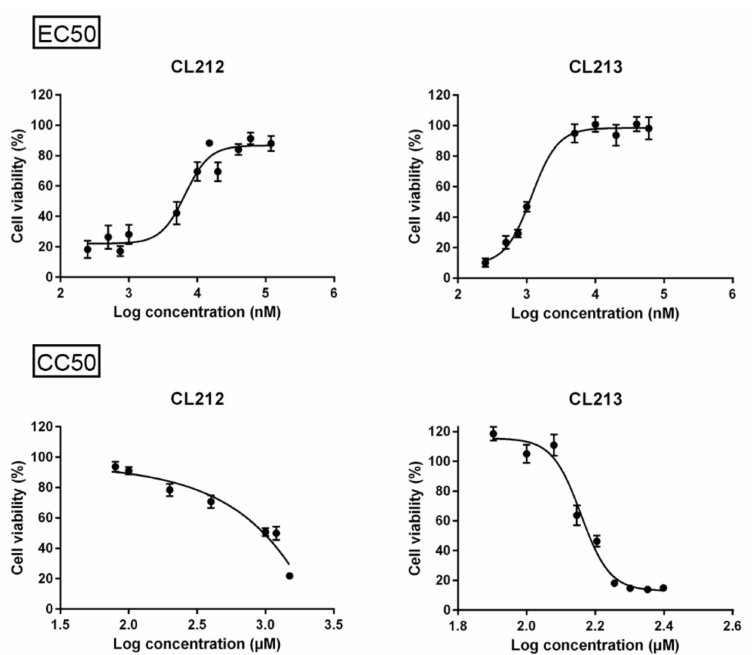
Figure 2. Dose-response curves of CL212 and CL213 to study their efficacy during CVA9 infection (upper panel) or cytotoxicity in A549 cells (lower panel). CVA9 (1.6 × 10 7 PFU/mL) was incubated with the molecules for 1 h at +37 ◦ C after which the virus-molecule mixture was added to cells (MOI 80). Cell viability was determined after 24 h using CPE assay (see materials and methods for details). The results are from two (EC50) or three (CC50) separate experiments with three technical replicates. The data is presented as mean ±